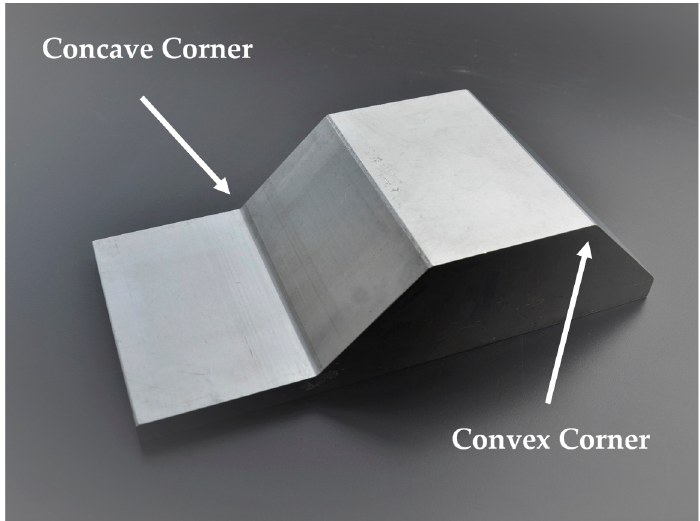
Figure 2. The mold with a concave corner and a convex corner inclined at 45°, used for the Figure2. Themoldwithaconcavecornerandaconvexcornerinclinedat45 ◦ , usedforthemanufacturing manufacturing of laminated composite samples. of laminated composite samples.